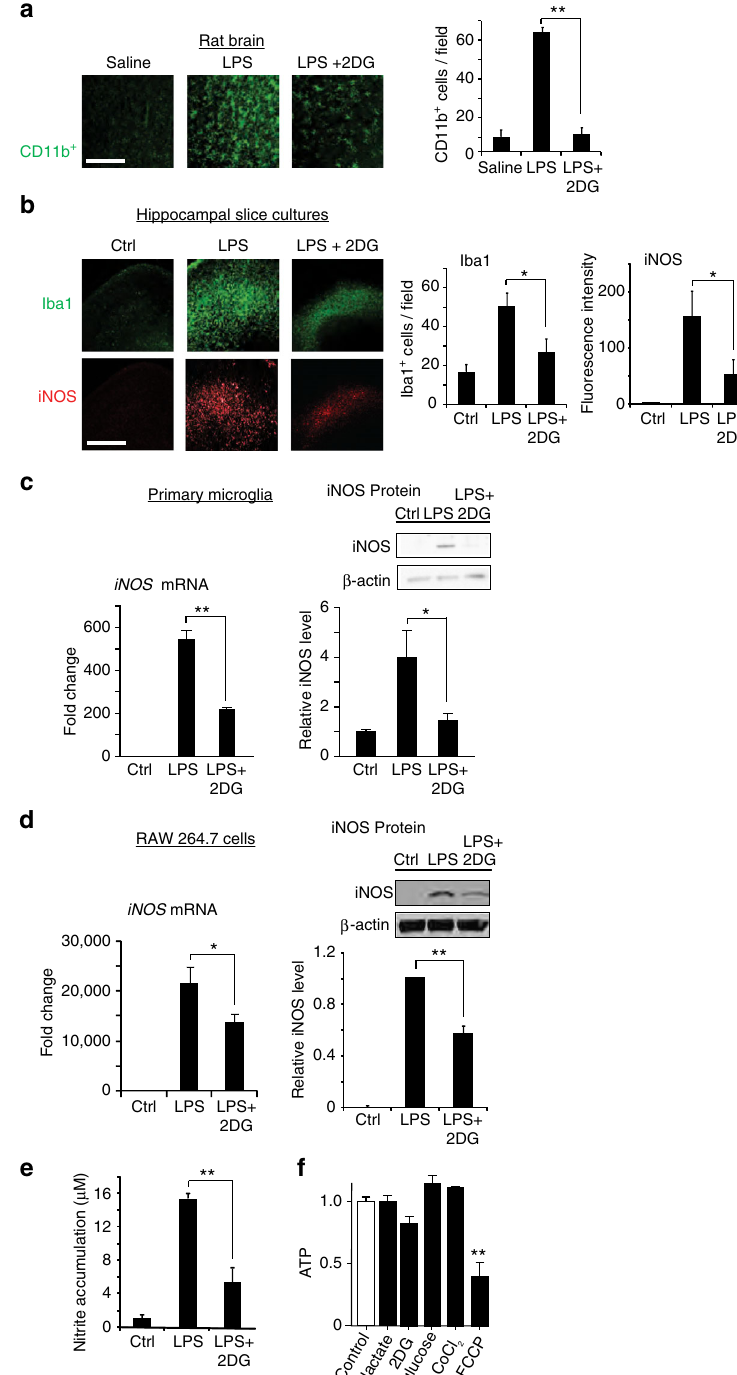
Fig. 1 2-deoxyglucose suppresses LPS-induced microglial activation. a Immunostaining for CD11b identi fi es activated microglia in rat hippocampus.